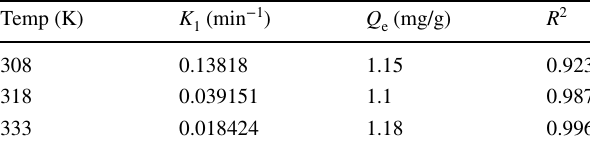
Table 4 Lagergren pseudo first order kinetic parameters for the adsorption of MG onto the Neem leaf adsorbent